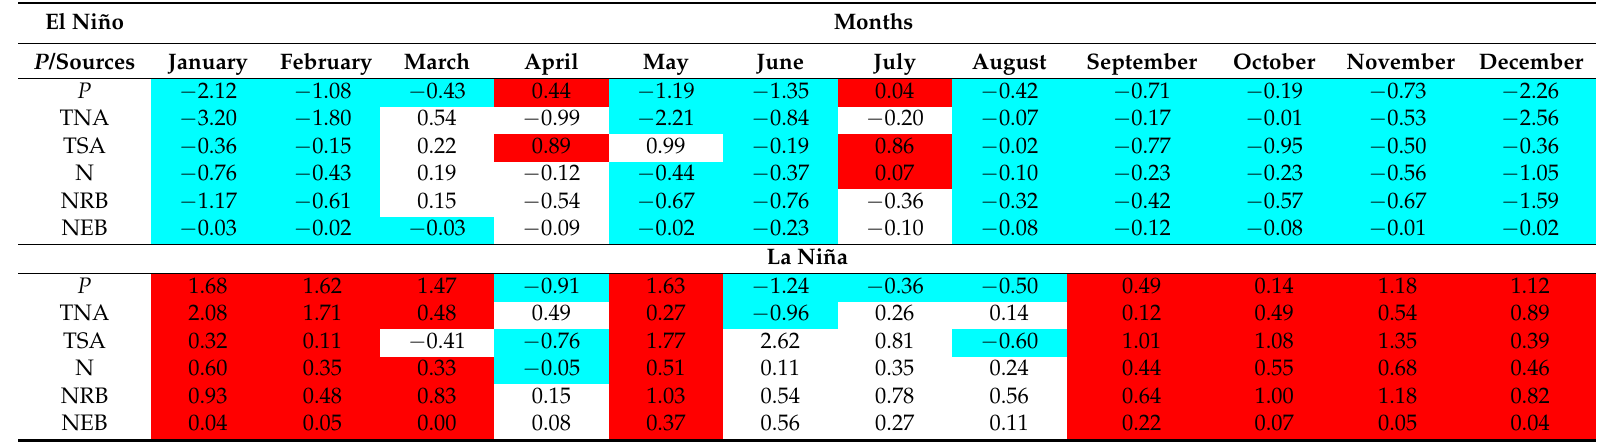
Table 5. Anomalies of P and |( E − P ) i10 < 0| in the NRB for the composite of months under El Niño and La Niña conditions. Simultaneous negative (positive) anomalies of P and |( E − P ) i10 < 0| are shaded in blue (red). Period: